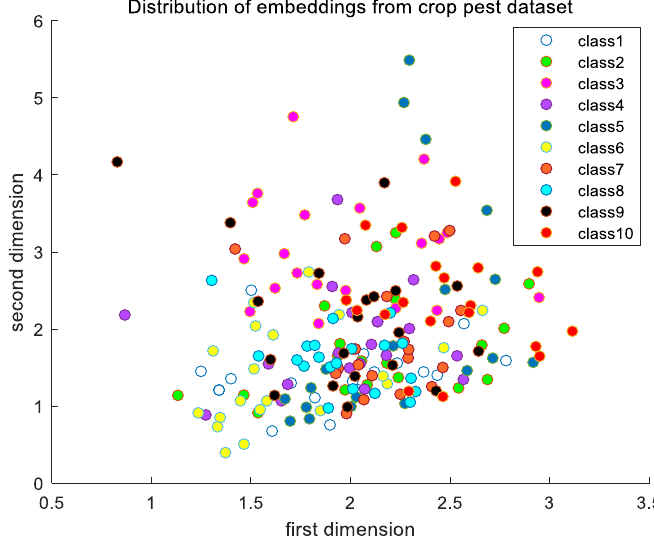
Figure 13. The distribution of embeddings from the old pest task.